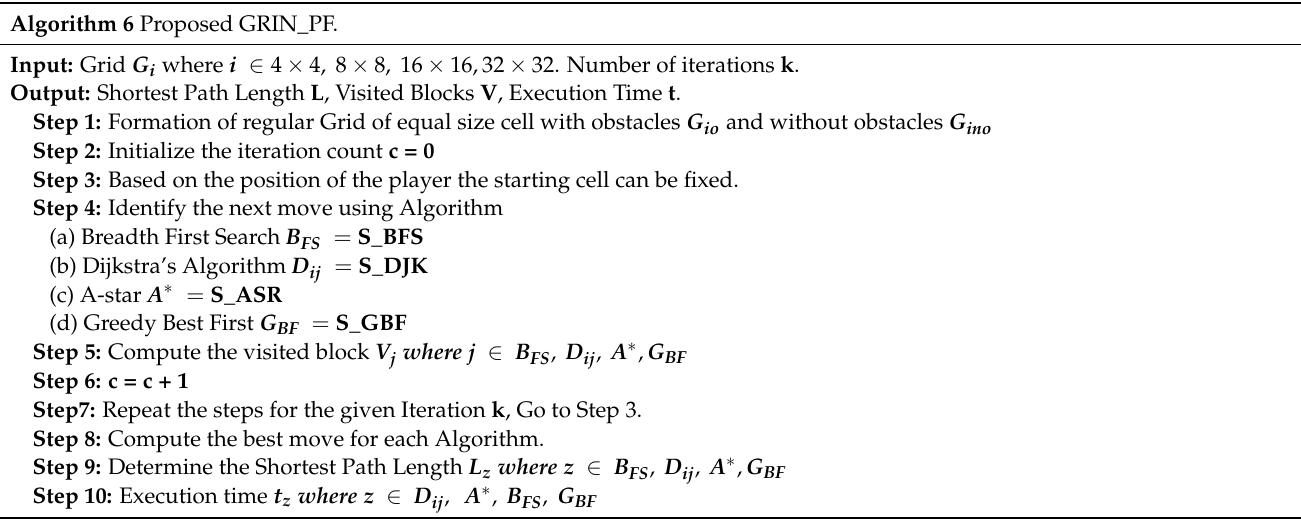
Algorithm 6 Proposed GRIN_PF.